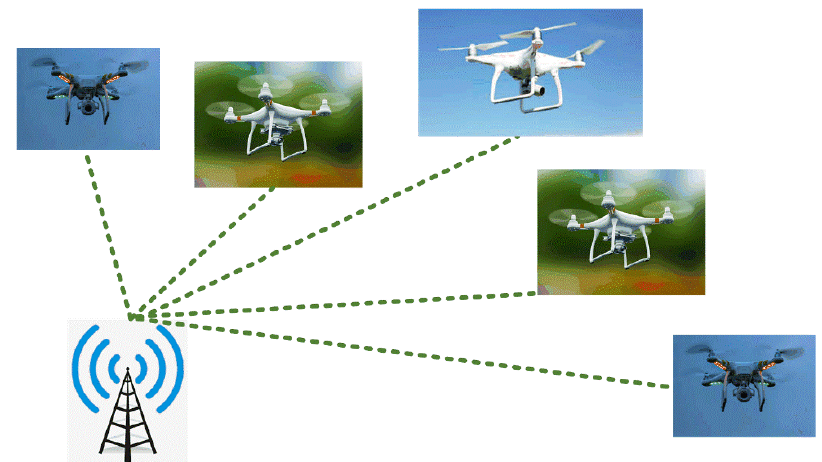
Figure 2. Generic drone communication architecture illustrating the communication between each drone and base station.